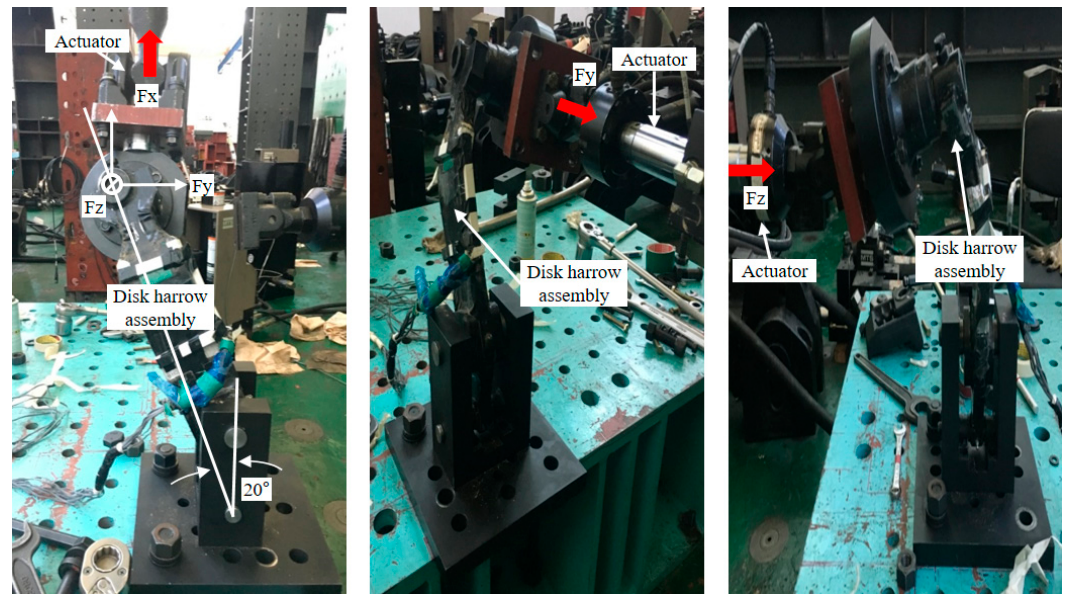
Figure 5. Static test of disk harrow assembly.